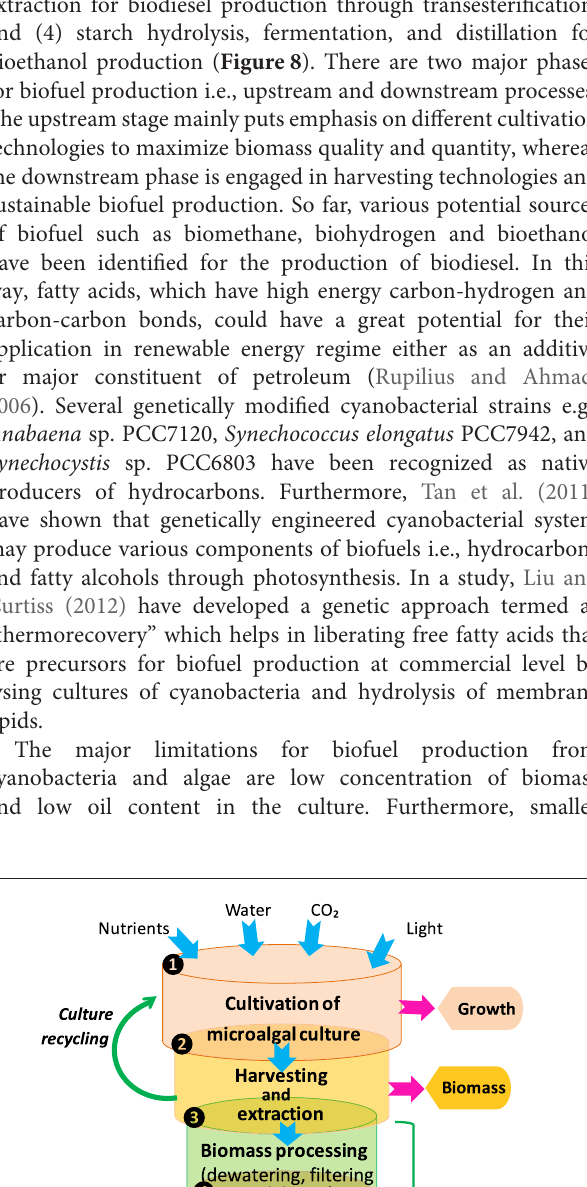
Frontiers in Microbiology |